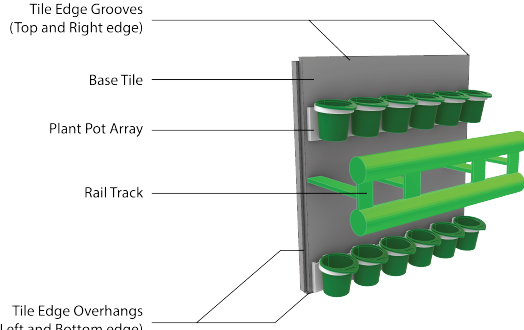
Figure 7. Groove and overhang system, closeup of a typical tile.